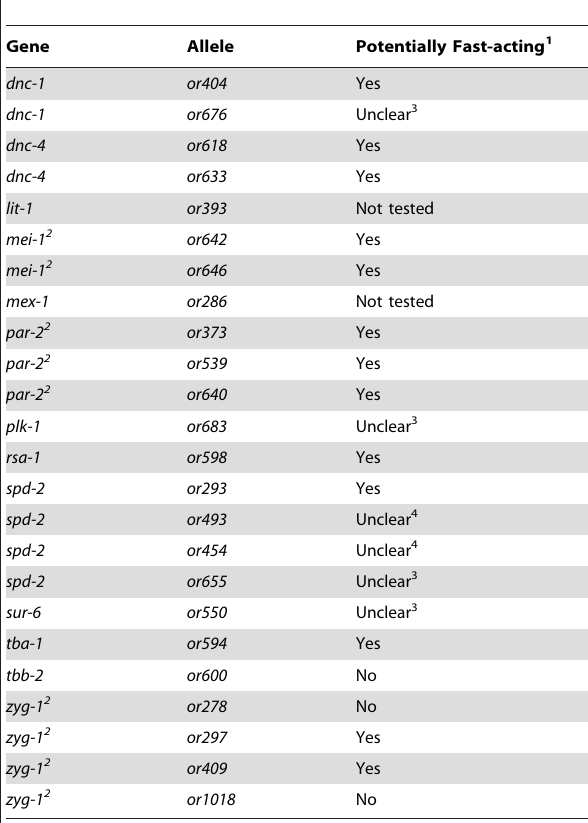
Table 3. Determination if the TS mutations are potentially fast-acting.